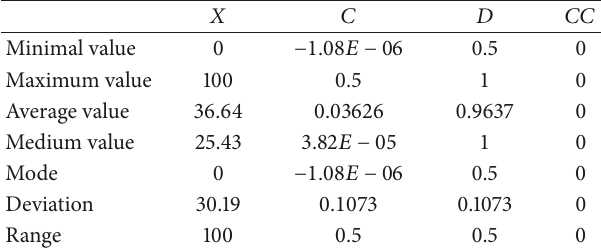
Figure 2: The state of population when 𝑥 = (0.5, 0.5 – 0.0001 , 0.0001) . Table 3: The statistical analyses of strategies 𝐶 , 𝐷 , and 𝐶𝐶